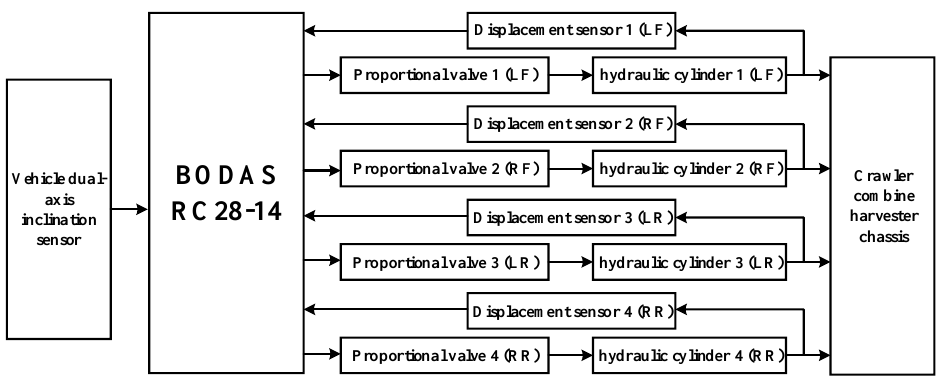
Figure 4. Structure diagram of the control system.